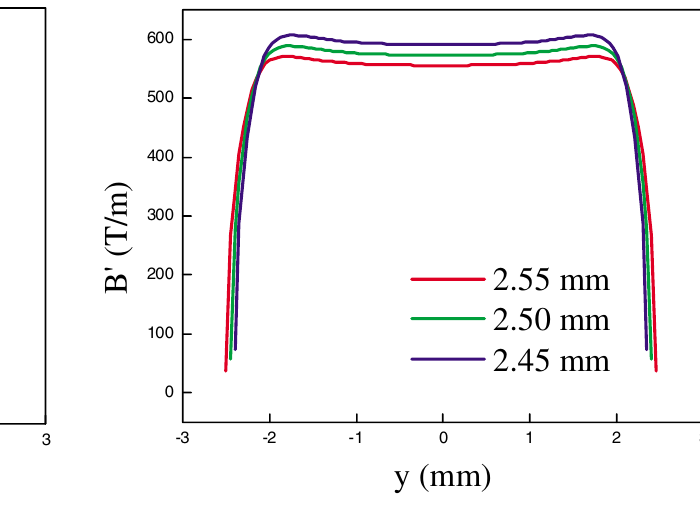
FIG. 6. (Color) Field dependence on magnet bore radius: r (cid:2) 2 : 45 mm (top), 2.50 mm (middle), and 2.55 mm